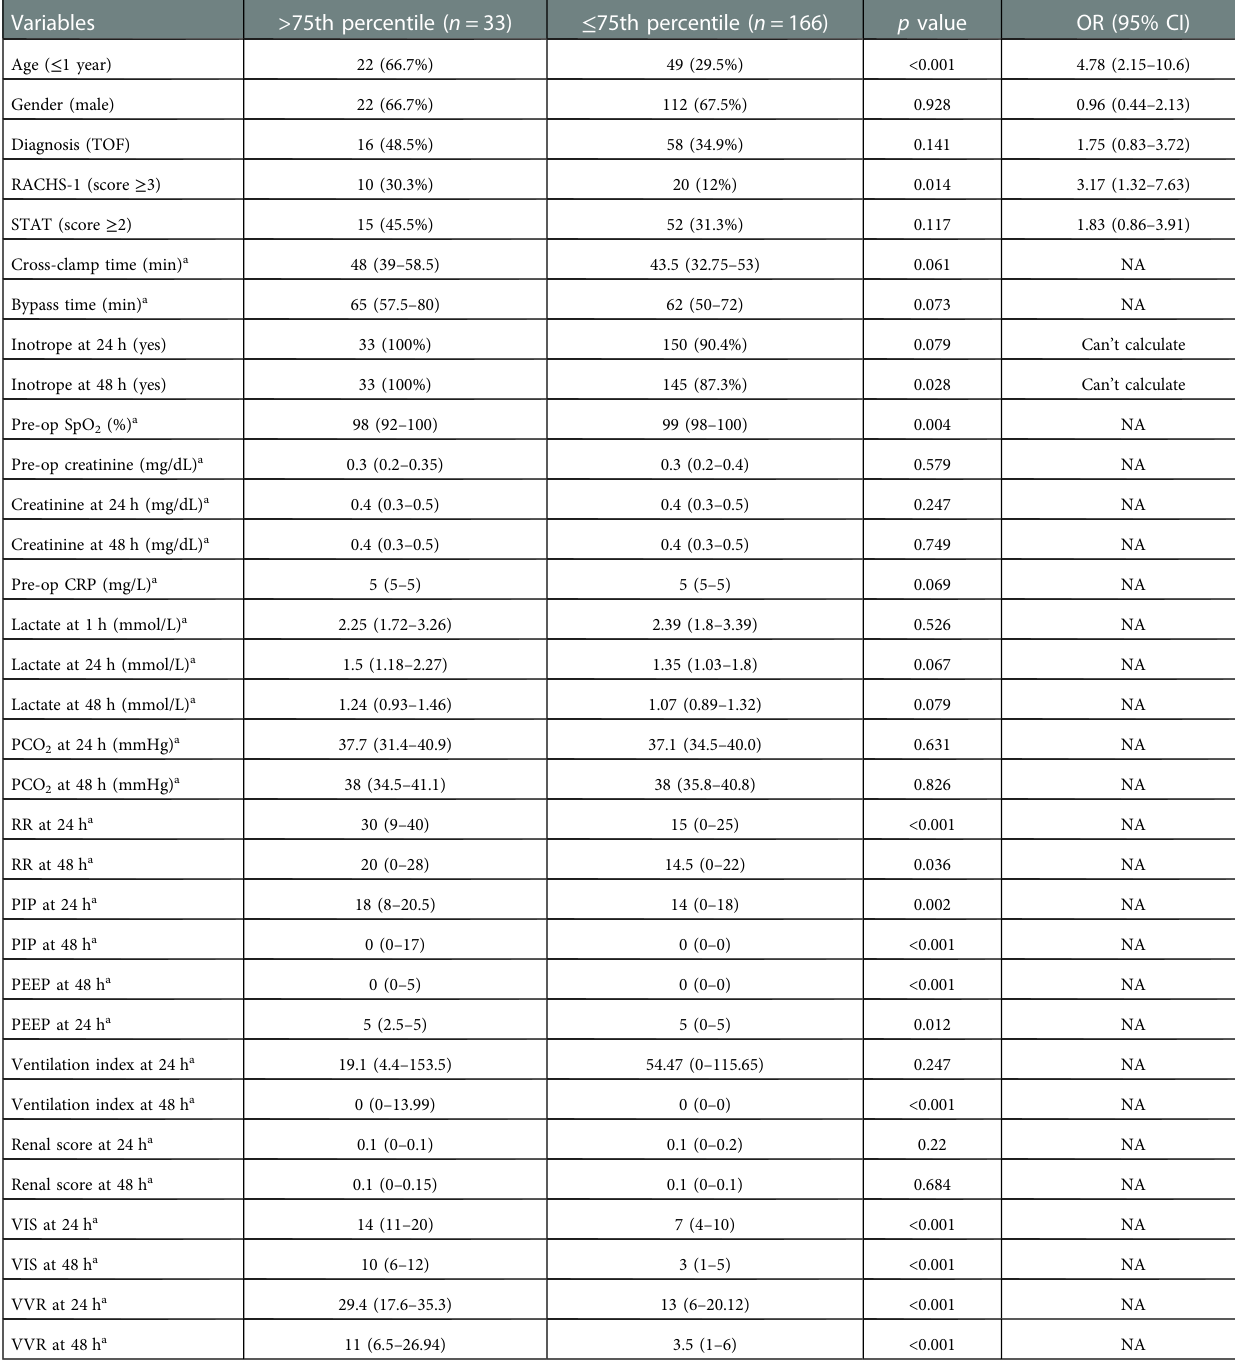
TABLE 3 Univariate analysis showing factors associated with prolonged ventilation duration (>20